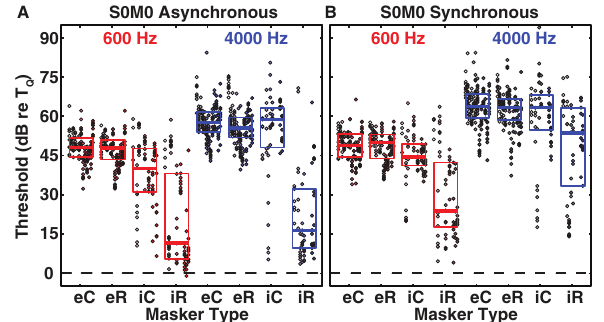
Figure 1. Signal detection thresholds re T Q , i.e. thresholds in the presence of a masker re threshold in quiet, for the all-pass maskers with the 600-Hz (red) and the 4000-Hz (blue) signals in the asynchronous (A) and synchronous (B) timing conditions for all masker types in the S0M0 (signal and masker co-located straight ahead) spatial configuration. Thresholds close to zero indicate little masking and large threshold values indicate strong masking effects. Data from individual subjects are shown as markers in different shades. The box indicates the 25 th , 75 th and 50 th percentiles. Note that not all subjects were tested on all masker-signal combina- tions. To facilitate identification of individual subjects we ordered the subjects consistently throughout the plots. Subject order is: S31, S32, S33, S36, S37, S39, S42, S51, S55, S56, S57, S58, S59. eC = energetic constant frequency masker; eR = energetic random frequency masker; iC = informational constant frequency masker; iR = informational random frequency